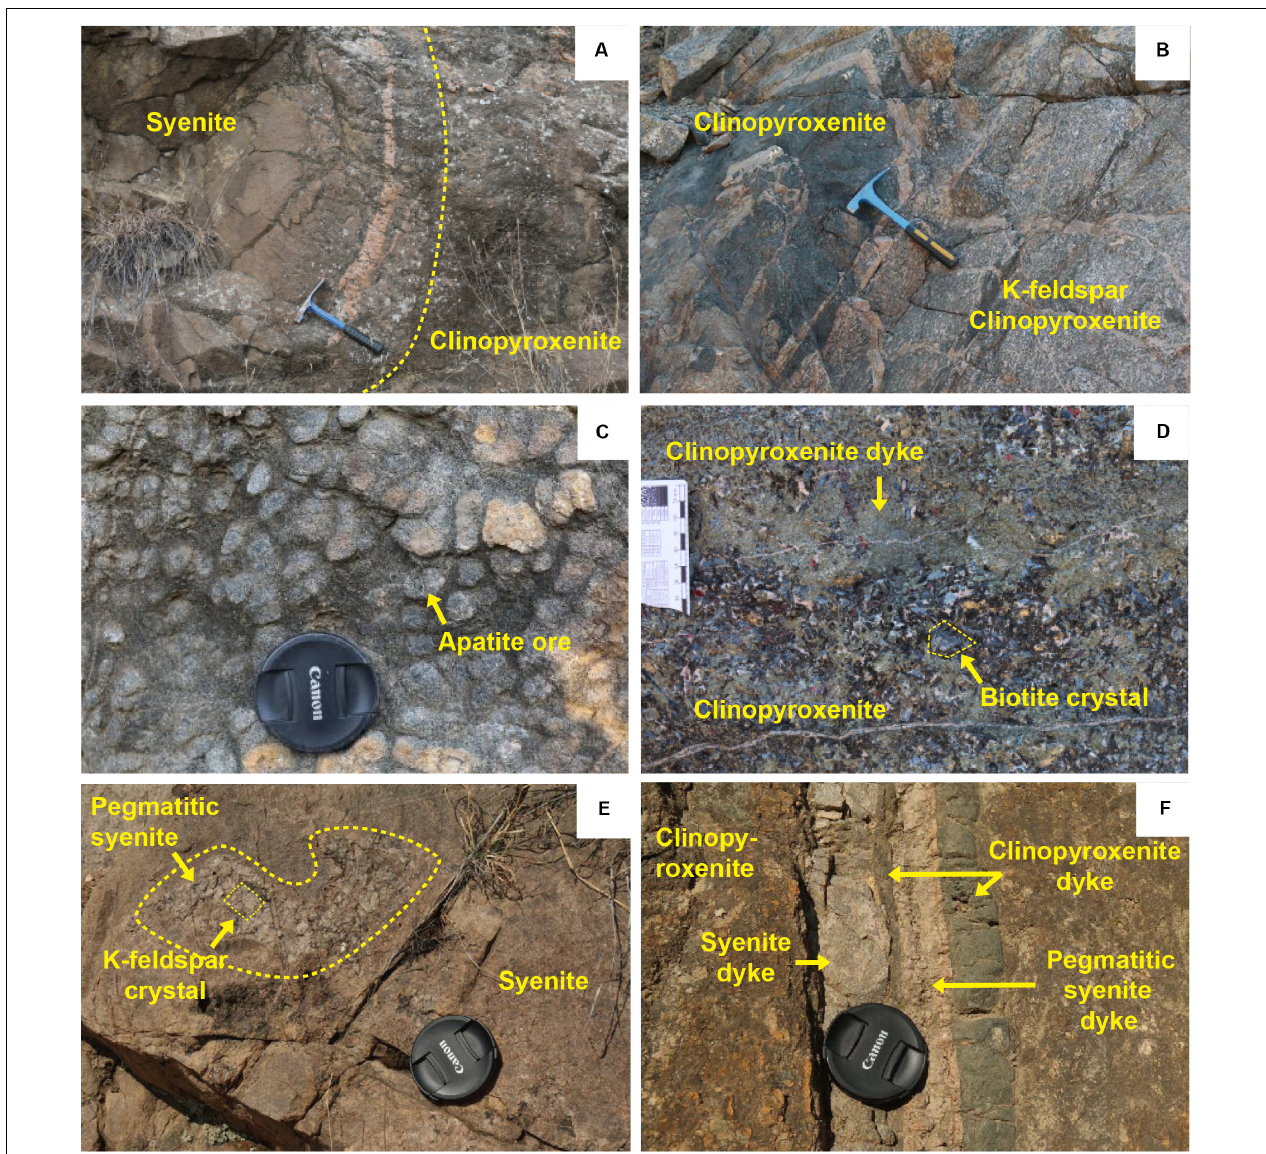
FIGURE 2 | Field photos showing the geology of Yaojiazhuang ultrapotassic intrusion. (A) Angular clinopyroxenite breccia at the boundary between syenite and clinopyroxenite. (B) Magma mingling between syenite and clinopyroxenite. (C) Intrusive contact between clinopyroxenite and K-feldspar clinopyroxenite. (D) Spheroidal apatite ores in clinopyroxenite. (E) Pegmatitic syenite at the center of the syenite unit. (F) Clinopyroxenite, syenite and pegmatitic syenite feeder dykes in the clinopyroxenite.